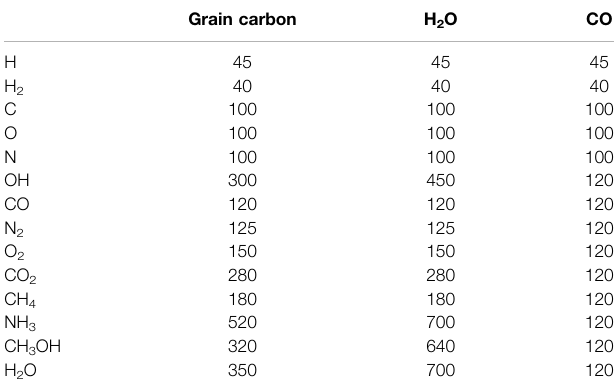
TABLE 3 | Pairwise potentials, ϵ (K), between selected surface